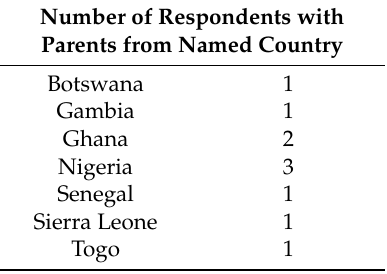
Table 6. Second-Generation African Respondents ( n =